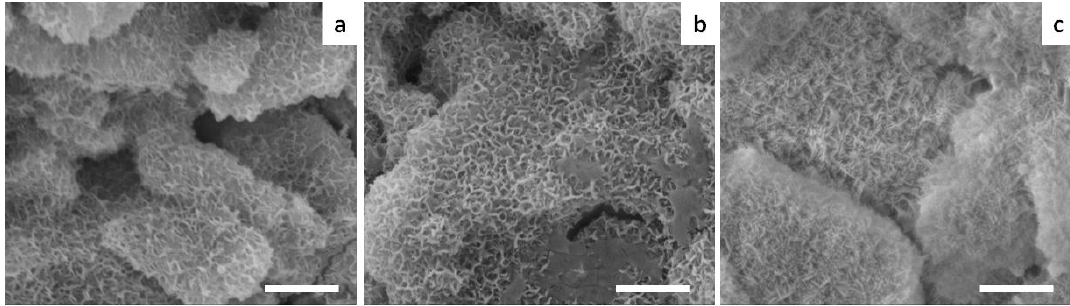
Figure 5. SEM micrographs of ( a ) Sr0; ( b ) Sr2; and ( c ) Sr5 cements. Scale bar: 2 µm.